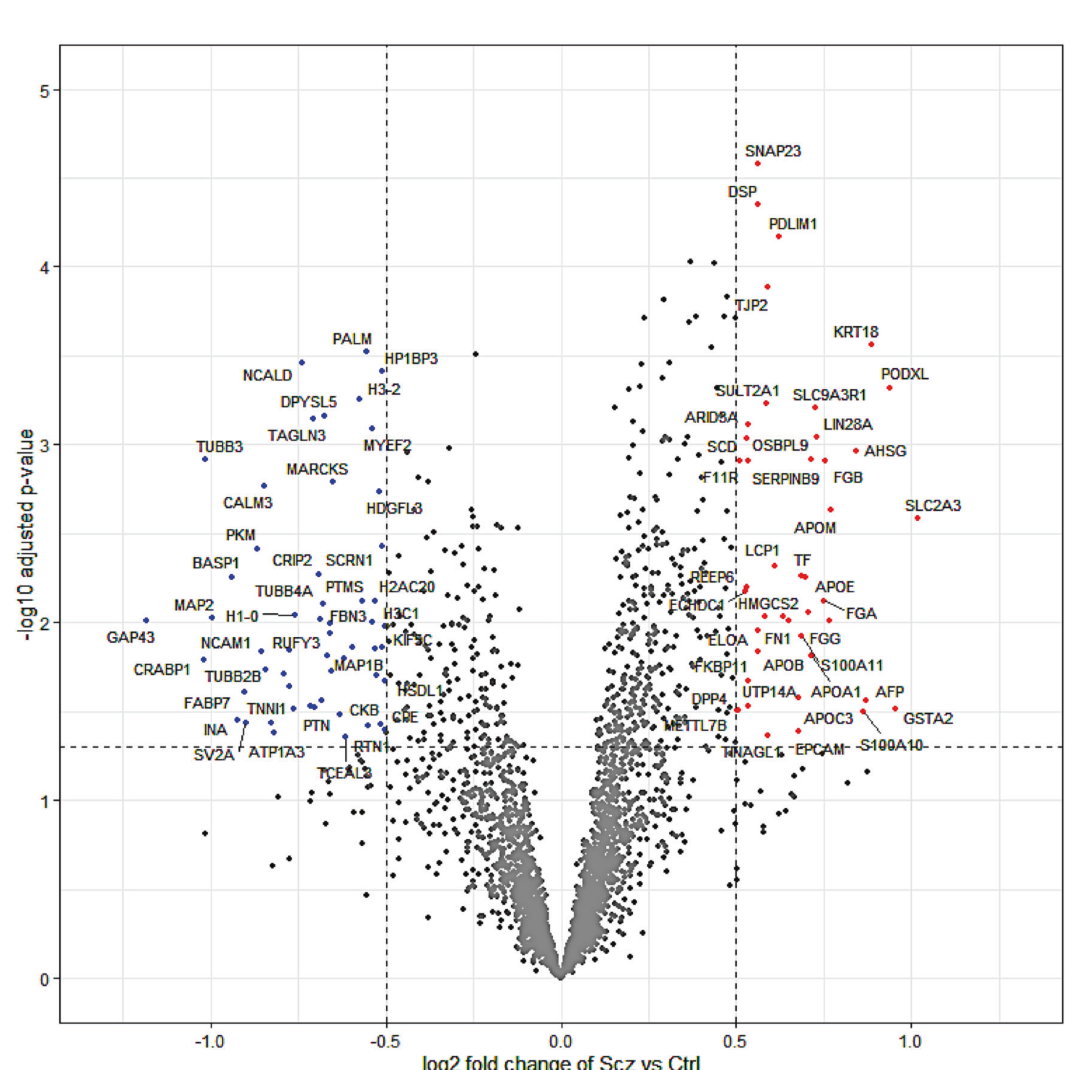
Fig. 2 Differential expression in the Scz cerebral organoid proteome. Principal component analysis of the cerebral organoid proteome indicated data grouping based on phenotype, and protein expression distributions indicated data correlation across all samples. This statistical baseline allowed us to consider the differentially expressed proteins present in Scz patient-derived cerebral organoids, which are shown here as a volcano plot split by log2 fold change and – log10 adjusted p values. In sum, ~2.62% of 3705 proteins (peptide >1; intensity >0) identi fi ed exhibited differential expression. Signi fi cantly up-regulated proteins that surpassed log2 fold change thresholding are depicted to the right in red ( p value <0.05, Log2FC > 0.05), whereas down-regulated proteins ( p value < 0.05, Log2FC < -0.05) are presented to the left of the plot in blue. Notable Scz GWAS factors (see 108 loci identi fi ed in [33]) included the up-regulation of PODXL and down-regulation of PTN, which replicated our previous fi ndings in a smaller cohort [1]. Note also the down-regulation of the neural stem cell proliferation factor CRABP1 [93] as well as canonical neuronal development markers (e.g. NCAM1 [94], NCALD [95], and CPE [78]), neuronal markers (e.g. MAP2, TUBB3, MAP1B), synaptic markers (e.g., SV2A). Conversely, a range of apolipoproteins (APOE, APOA1, APOB, APOC3) were found to be up- regulated in Scz patient-derived cerebral and pathways yields enrichment for pathways presumably pathways that were up-regulated in Scz organoids comprised involved in either compensation or other disease-related post-translational protein phosphorylation, pathways related to neuropathology including phenotypes that have possibly not MAPK signaling, and IGF-related pathways. Overall, these data yet been articulated in human-derived tissue (e.g. speci fi c suggest that ying-and-yang alterations in Scz organoids exist, metabolic changes). whereby the disruption of neuronal-development factors